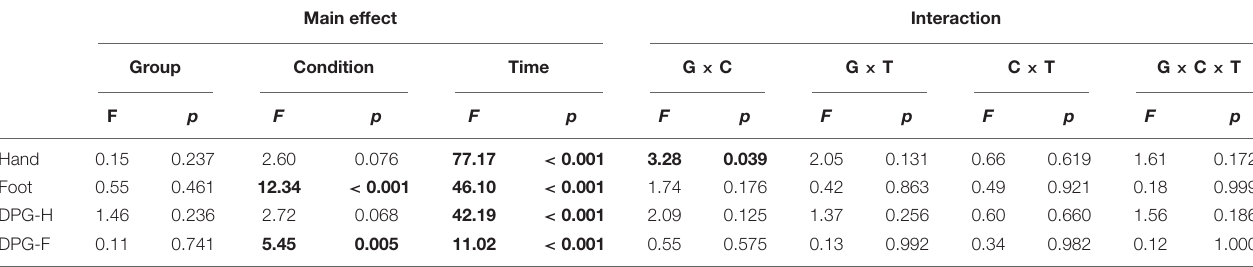
TABLE 3 | Summary of the statistical results in the changes of skin temperature